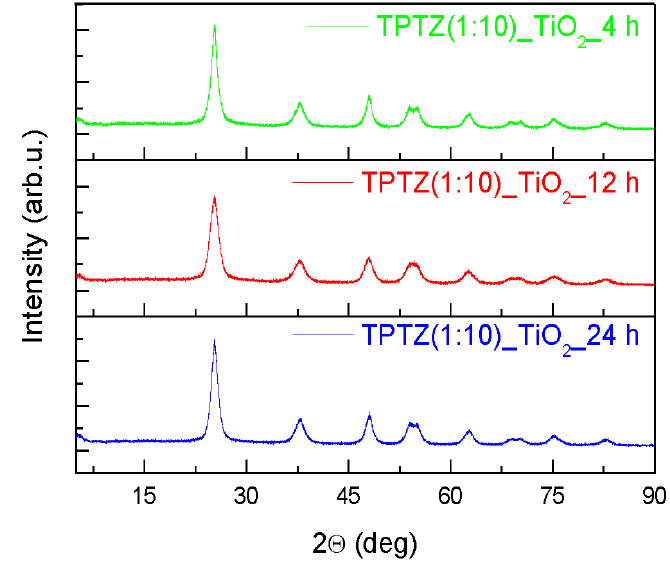
Figure 4. The XRD patterns of the TiO 2 samples prepared by the 2,3,5-triphenyltetrazolium chloride-assisted solvothermal method at variable time periods (4, 12, and 24 h).